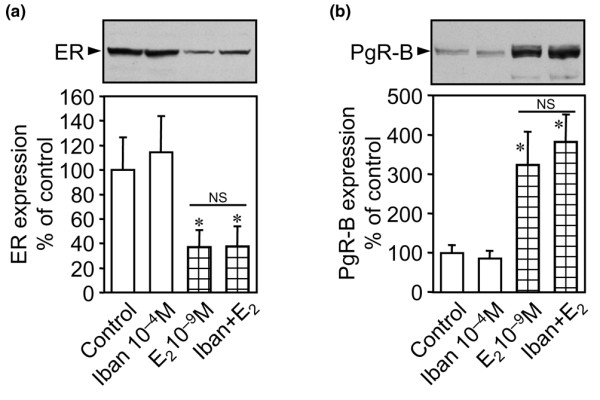
Estrogen receptor (ER) and progesterone receptor (PgR) expression in MCF-7 cells exposed to ibandronate (Iban) and/or 17β-estradiol (E2) as assessed by western blot. (a) For ER determination, MCF-7 cells were incubated for 24 hours with 10-4 M Iban and/or 10-9 M E2 or vehicle (control) in steroid-free medium. Equal quantities of proteins (20 μg) were subjected to SDS-PAGE and electrotransferred onto nitrocellulose membranes. Immunodetection was performed with anti-human ER antibody raised against its F domain. (b) For PgR measurement, cells were incubated for 72 hours in the same experimental conditions. Equal amounts of proteins (40 μg) were loaded onto SDS-PAGE and immunoblot was revealed using anti-human PgR antibody raised against A/B isoforms of the receptor. Blots show representative experiments performed at least twice. Data were obtained from densitometric analyses and are presented as mean percentages of control values. Asterisks indicate ANOVA p < 0.01 versus control, Tukey post hoc test. NS, not significant.